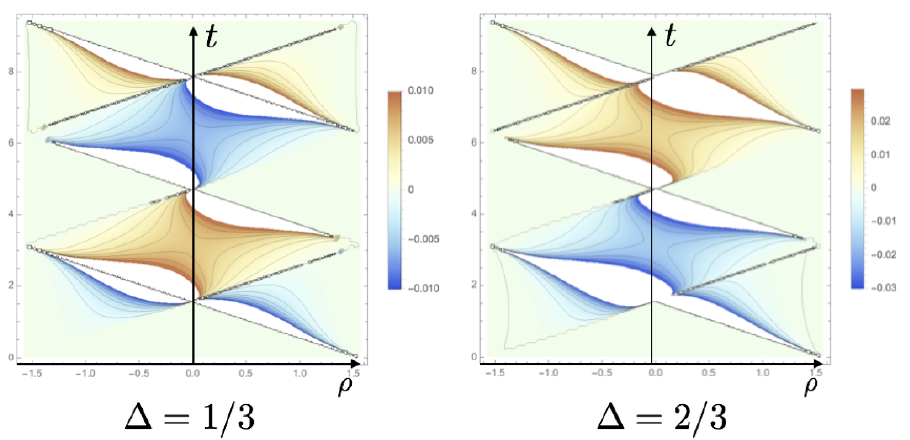
Figure 3 . Plots of null energy T (cid:21)(cid:21) in the bulk on (cid:18) = 0 (and = (cid:25) ) plane. U is taken to be (cid:18) growing direction. We can observe non zero null energy is emitted from the two points where we inserted double trace deformation. Note that on any null geodesic incoming from (cid:18) = (cid:25) and (cid:0) (cid:25) < (cid:18) < 0, null energy is negative, when g is positive. This result is (cid:1) independent.